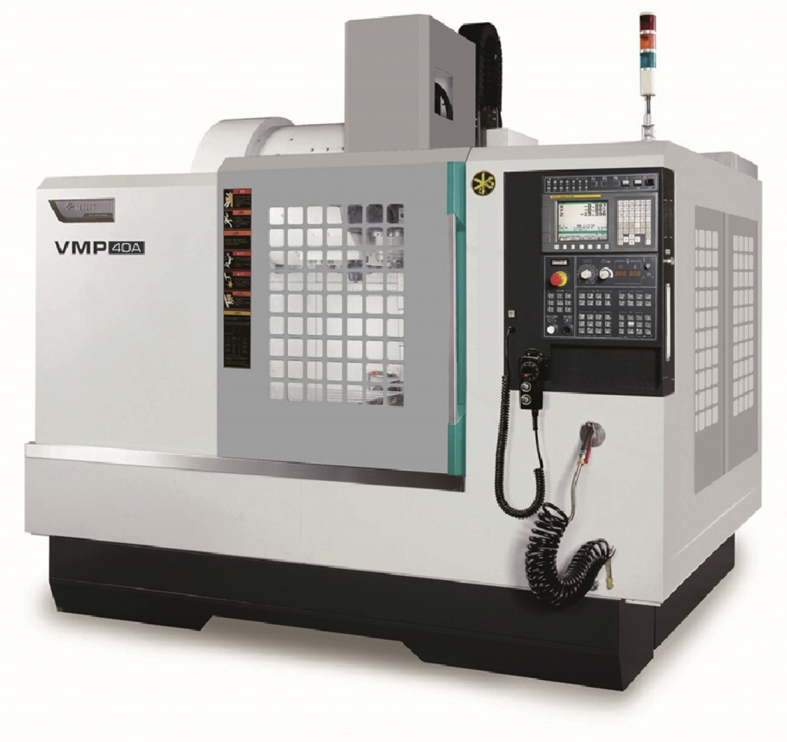
FFG VMP-40(A) machine center.